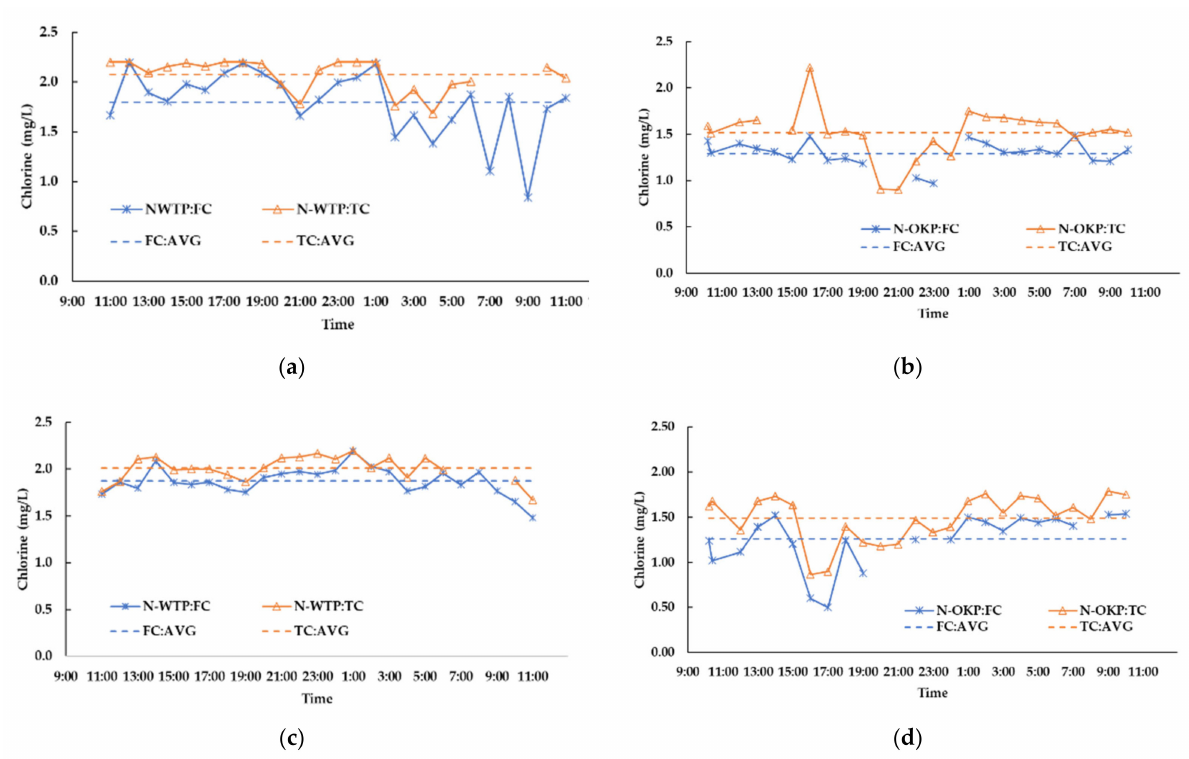
Figure 11. Twenty-four-hour chlorine monitoring at N-WTP Outlet and N-OKP Inlet: ( a ) N-WTP (Phase 1), ( b ) N-OKP (Phase 1), ( c ) N-WTP (Phase 2), ( d ) N-OKP (Phase 2).